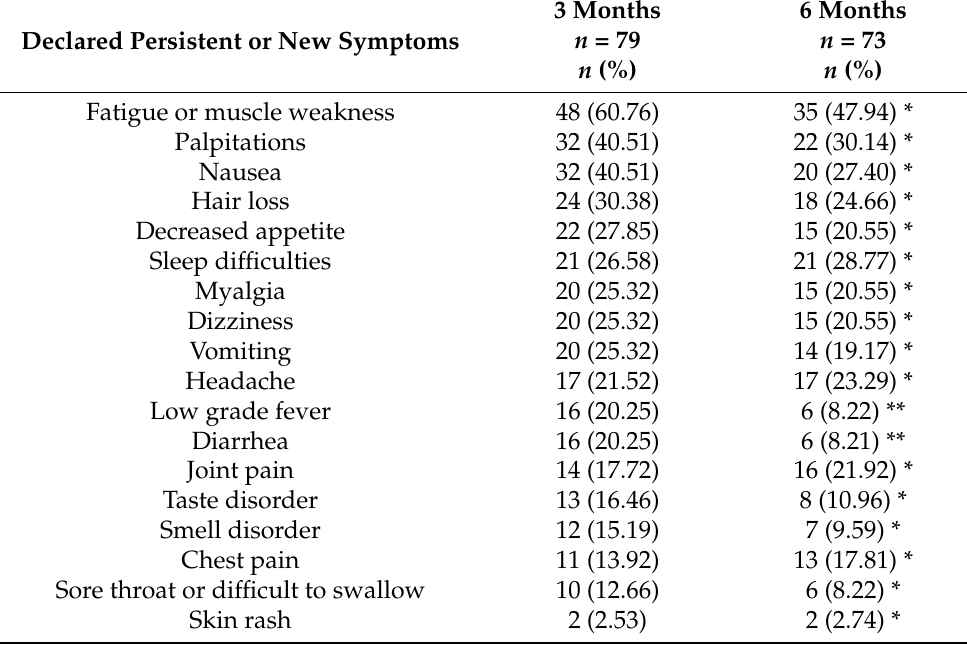
Table 2. Self-reported symptoms in SRSQ questionnaire.